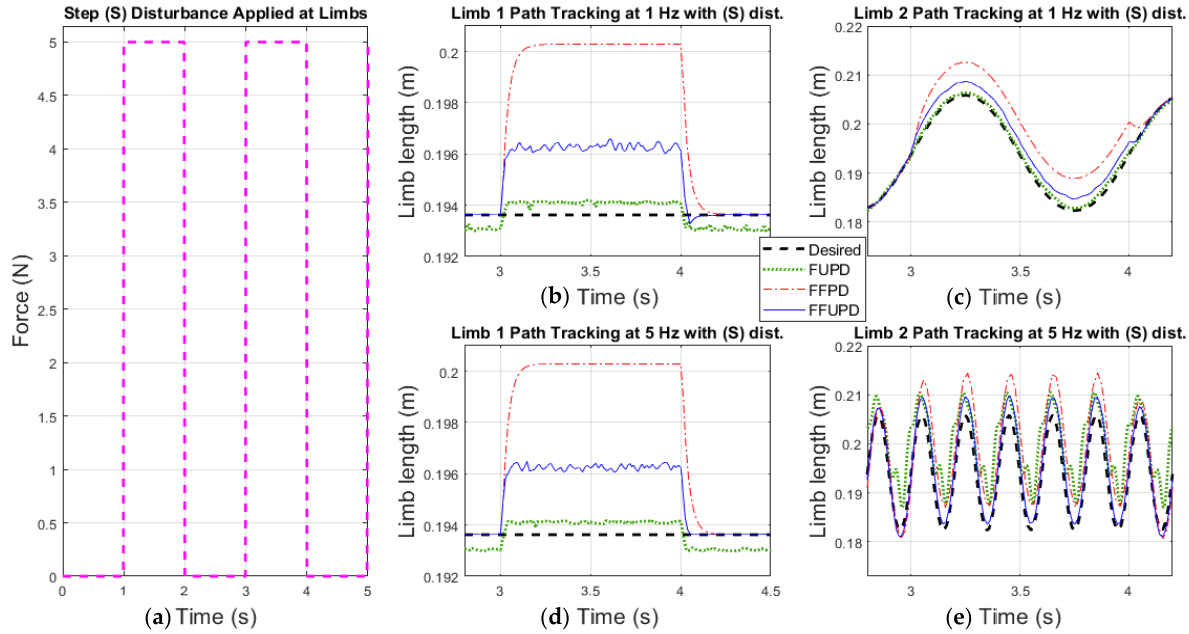
Figure 13. ( a ) Step disturbance applied to limbs’ line of action; ( b , d ): limb 1 controlled by FUPD, FFPD and FFUPD during perturbation at 1 and 5 Hz respectively; ( c , e ): limb 2 behavior at 1 and 5 Hz (respectively) during perturbation.